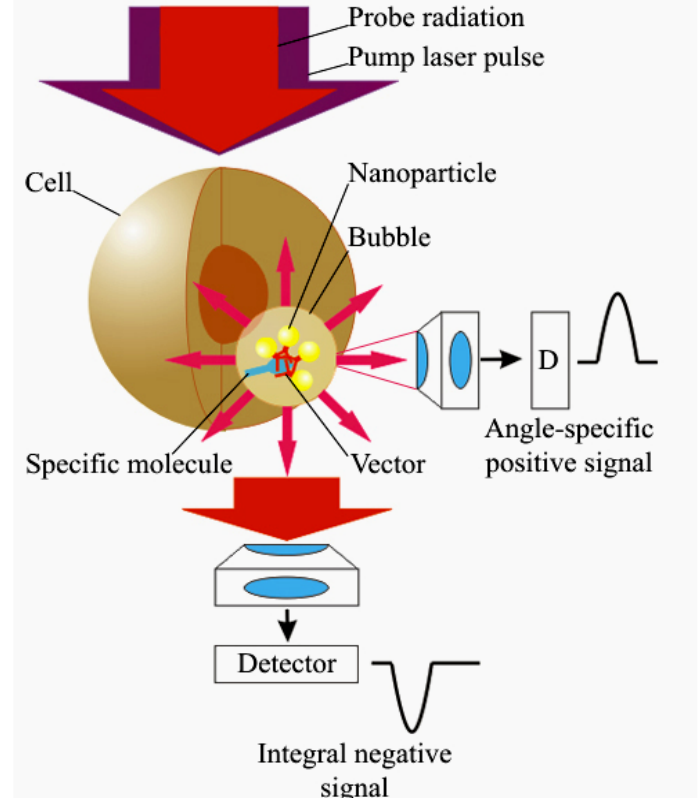
Figure 6. Principle of PNB amplification of optical scattering from an intracellular target: amplitude of the optical signal can be increased through formation of a target-linked NP cluster, and through generating a transient bubble around the NP cluster; the PNB may be detected with a scattered probe laser beam (pulsed or continuous) as an angle-specific positive signal or an integral negative signal